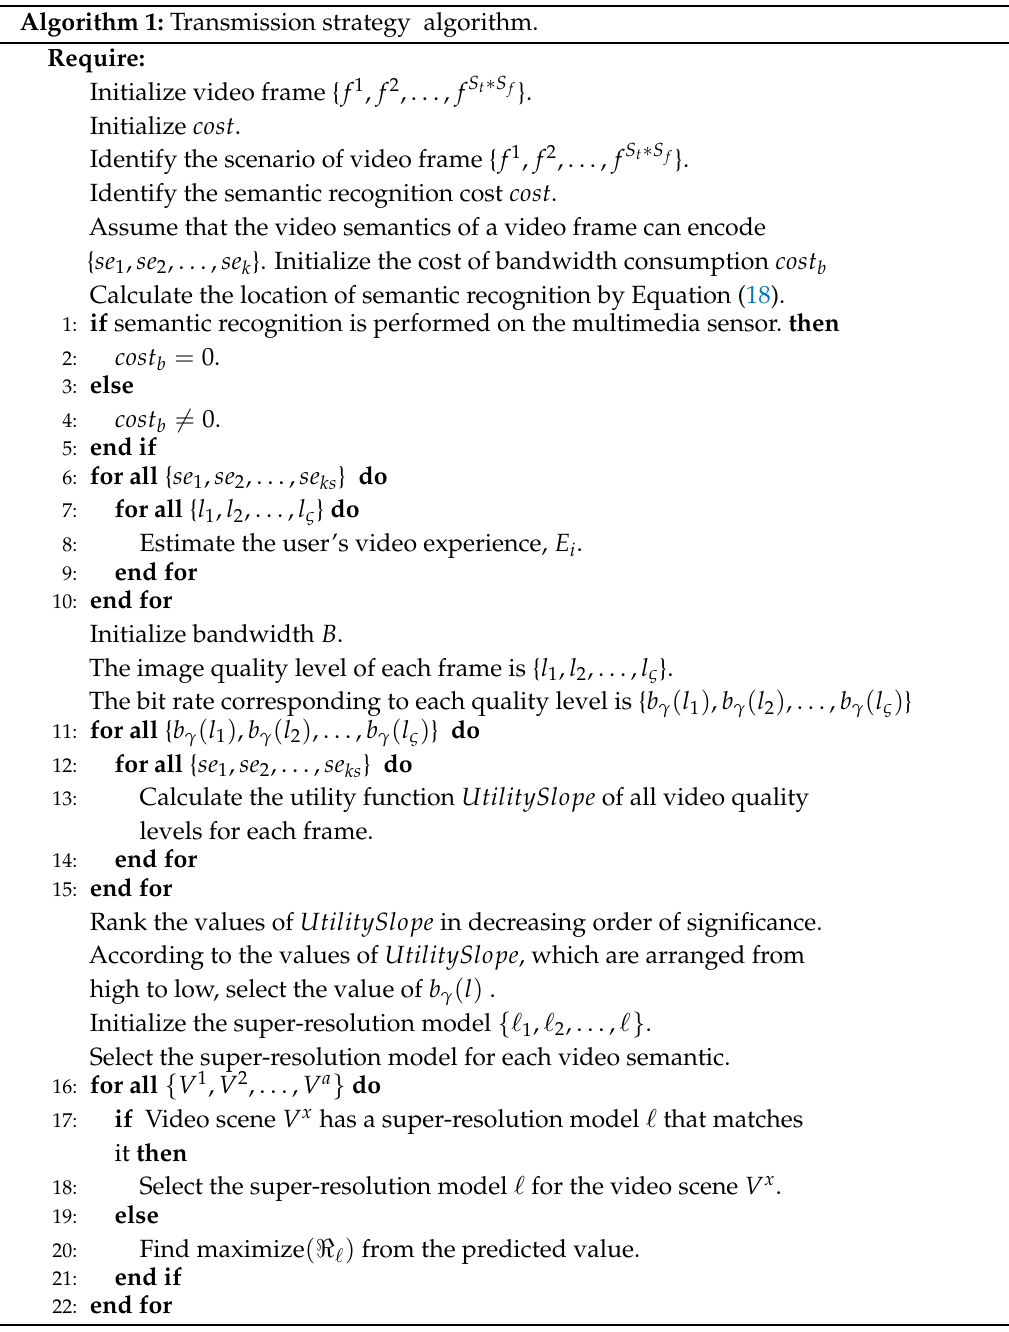
Algorithm 1: Transmission strategy